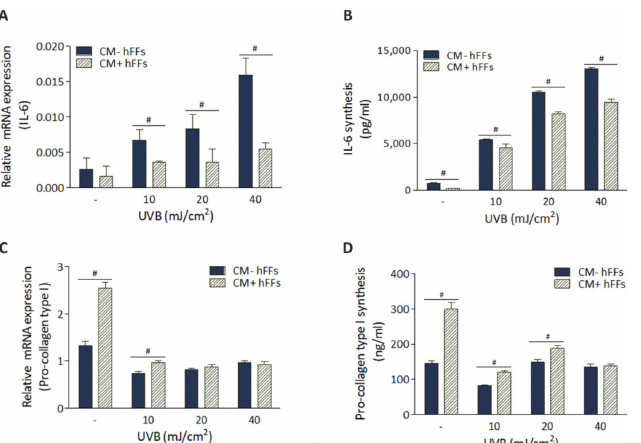
Figure 6. HC016-CM treatment reduces the expression of UVB-induced IL-6 and promotes the expression of pro-collagen type I in hFFs. Reverse transcription-quantitative polymerase chain reaction (qPCR) analysis of ( A ) IL-6 and ( C ) pro-collagen I at 24 h post-UVB irradiation. Biosynthesis of ( B ) IL-6 and ( D ) pro-collagen type I measured by ELISA 24 h after irradiation. Data are expressed as mean ± SD. # p <